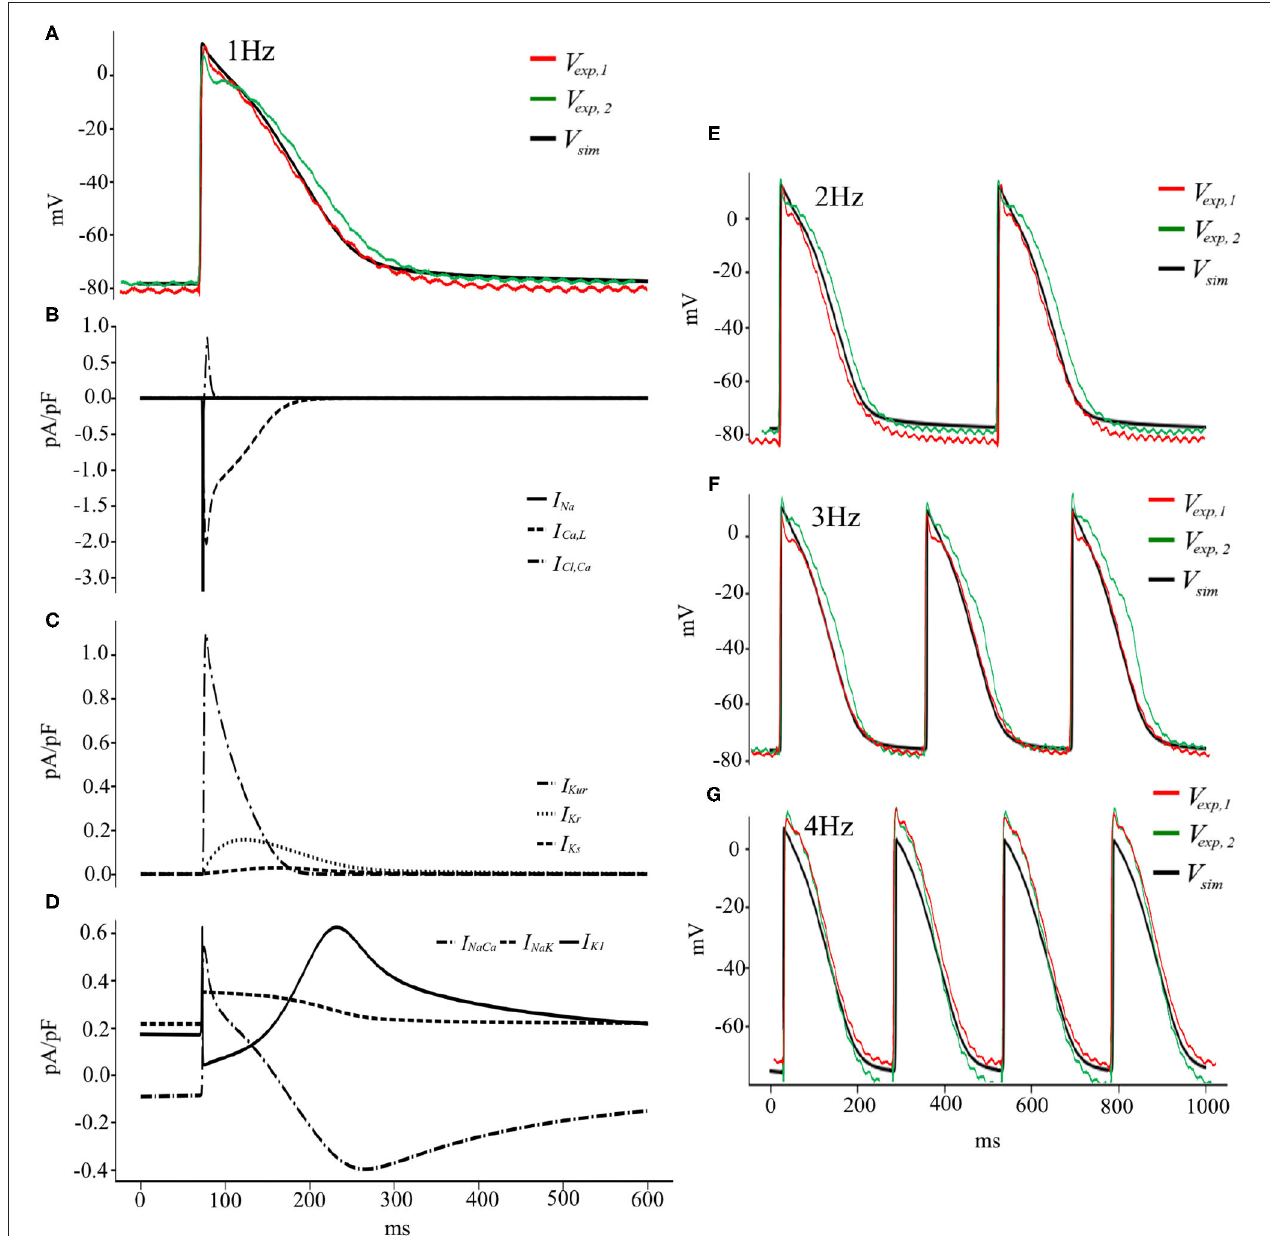
FIGURE 9 | (A) Voltage and Current traces (B–D) of a pig atrial action potential at 1 Hz pacing. Simulated (solid black) and experimentally measured (green and red) traces of AP recordings from cardiac tissue. (E–G) Voltage traces, both simulated (black) and experimental (green and red), at pacing frequencies of 2, 3, and 4 Hz,